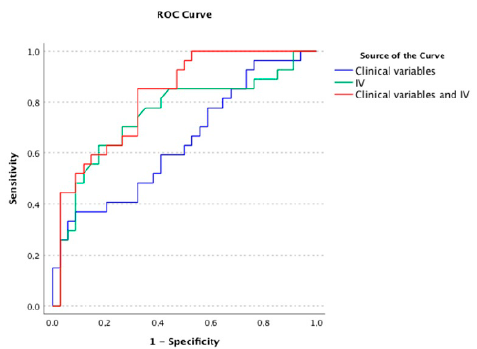
Figure 2. AUC of early versus later recurrence when classified using key clinical and circadian var-